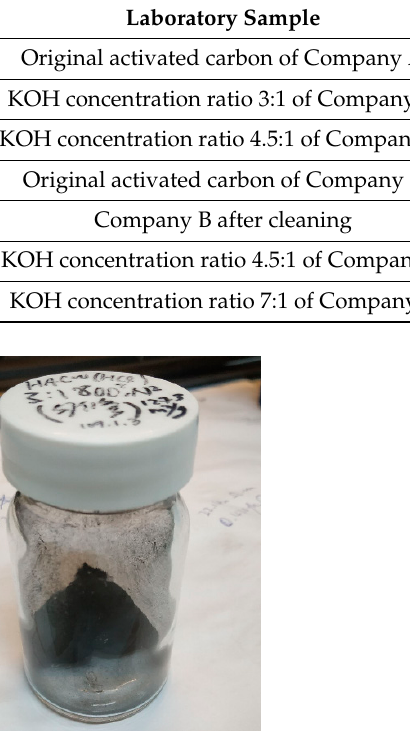
Figure 7. End product of activated carbon .